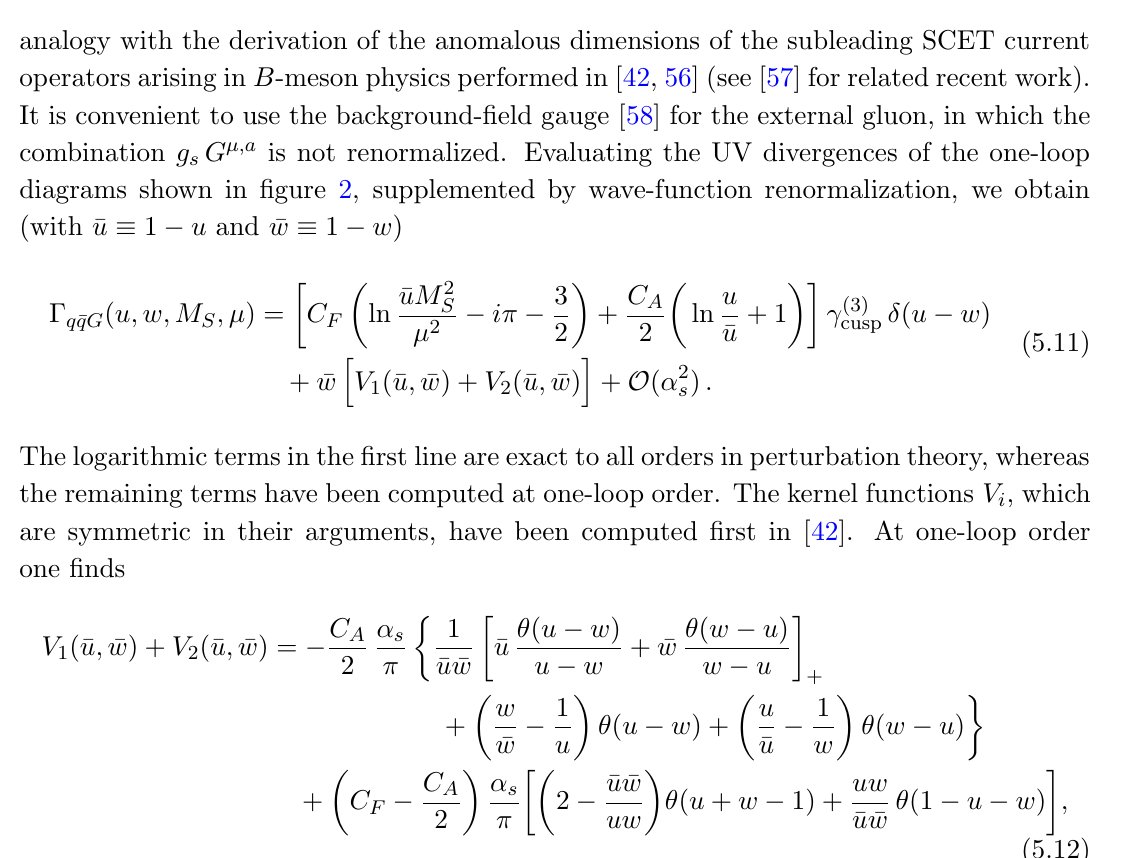
Figure 3 . Left: one-loop diagram responsible for the mixing of the operators O O q into the three mixed-chirality operators in (3.23). A dashed line ended by a cross indicates R (cid:22) q R G a zero-momentum scalar (cid:12)eld (cid:8) 0 , while a dashed line bending to the right shows a collinear scalar (cid:12)eld. Right: mixing of the ( (cid:21) 2 ) operators O GG and e O GG into the operator O Q O subleading interactions in the SCET Lagrangian. The dotted line represents an ultra-soft